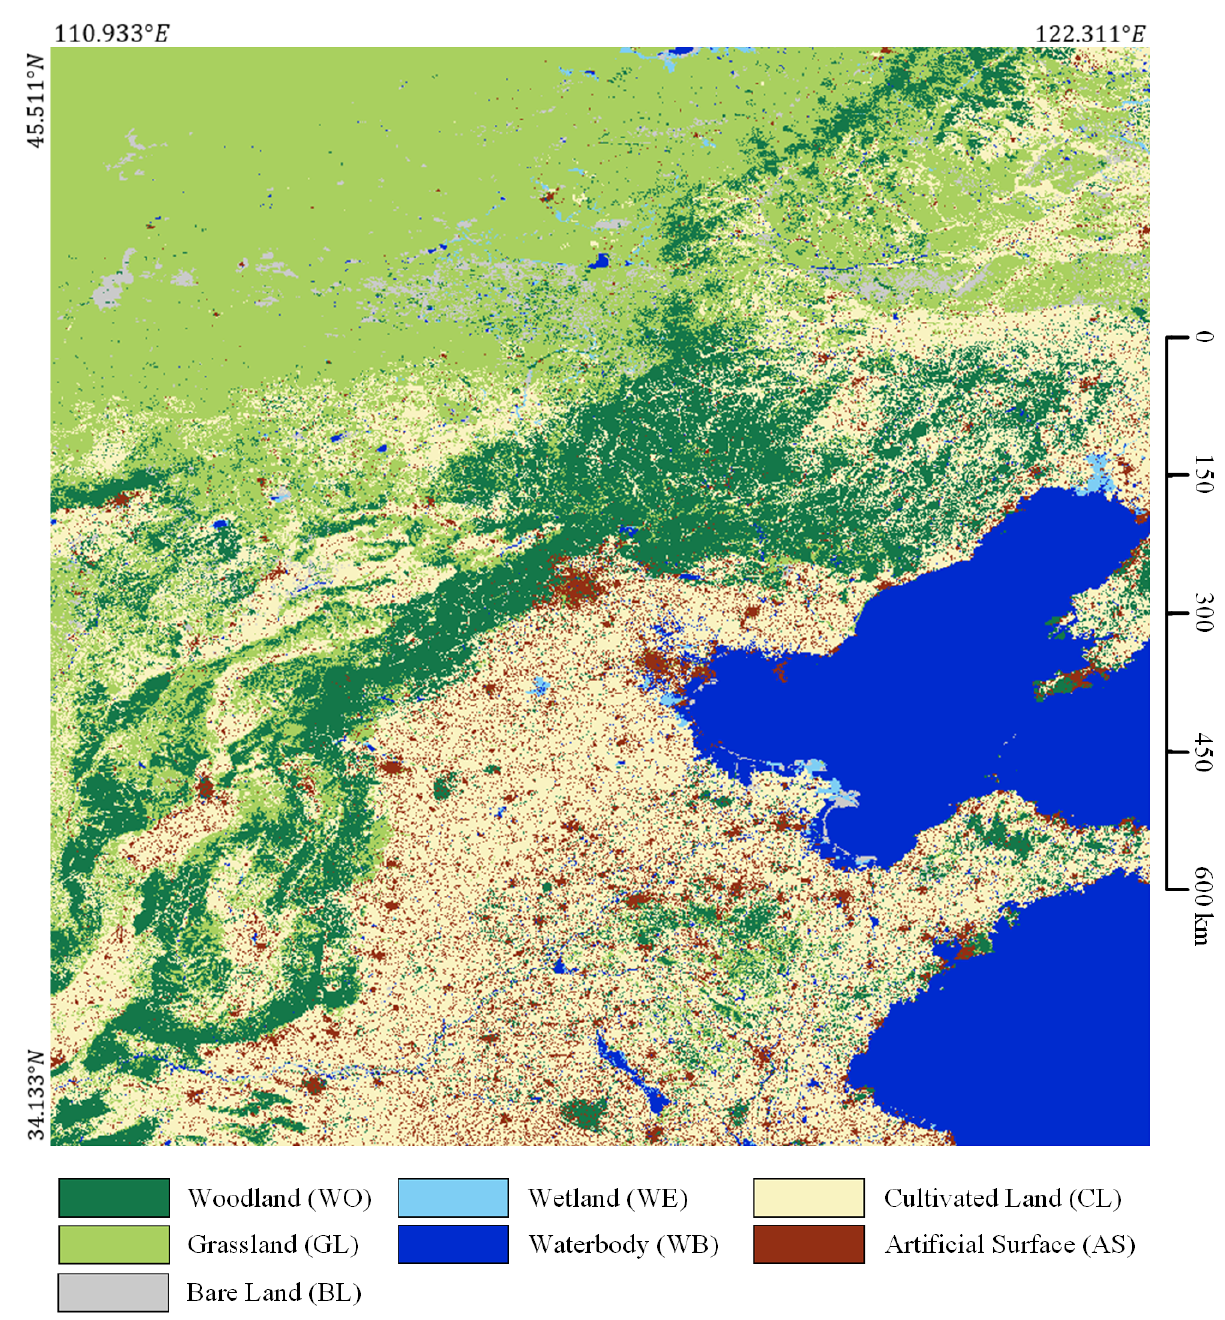
Figure 17. Large-scale classification results in parts of North